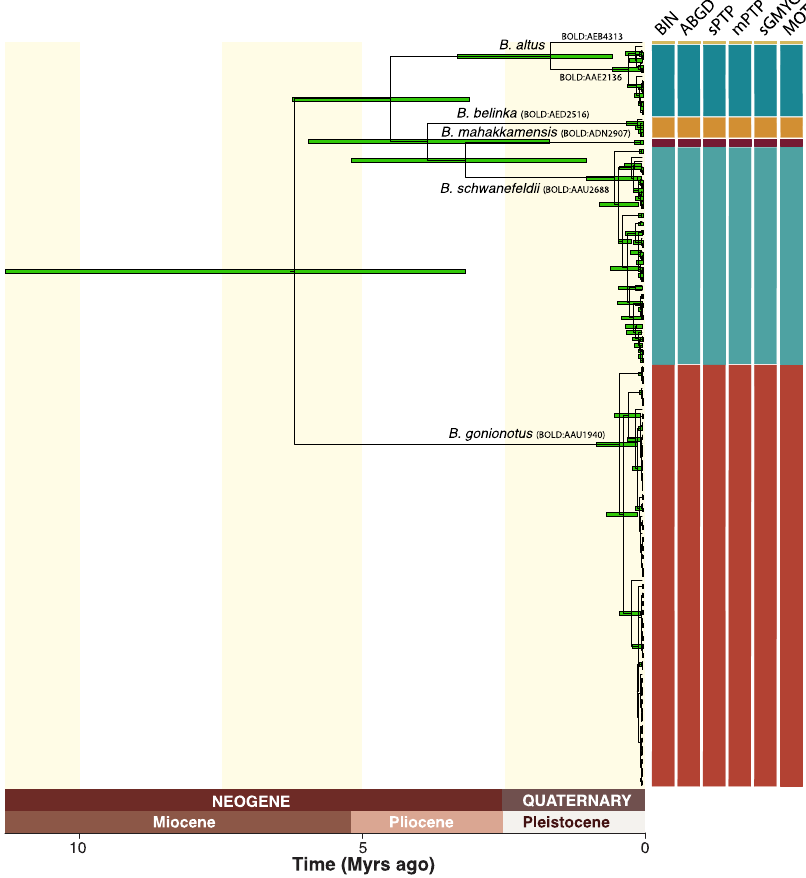
Figure 2. Mitochondrial gene tree for the 173 DNA barcodes of Barbonymus inferred with SpeciesTreeUCLN, including 95% HPD interval for node age estimates, genetic species delimitation results for five methods (mGMYC discarded) and their 50% consensus, BOLD Barcode Index Numbers (BIN) for each MOTU, and revised species names. Table 2. Summary of genetic distances and MOTUs including species names, number of individuals analyzed, BOLD Barcode Index Number (BIN), maximum intraspecific and minimum interspecific K2P genetic distances.